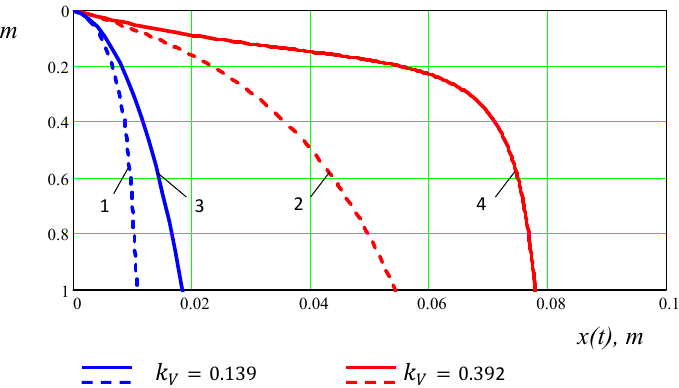
Figure 5. The trajectory of the movement of grains in the pneumatic gravity separator: 1 and 2 are direct channels; 3 and 4 are channels with variable cross section.